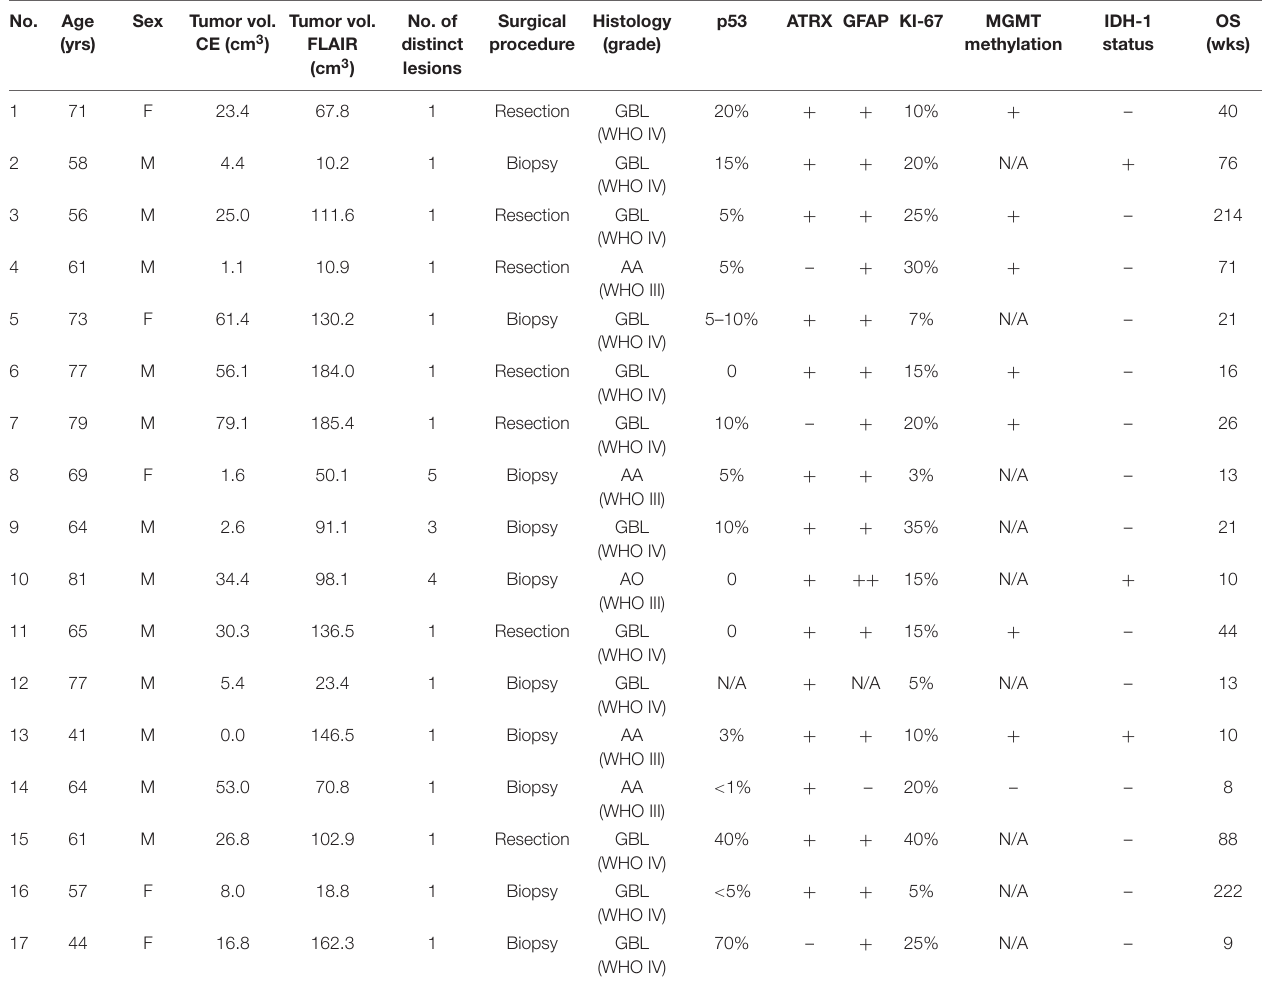
TABLE 1 | Patient demographic, histopathologic, and survival data. No. Age (yrs)